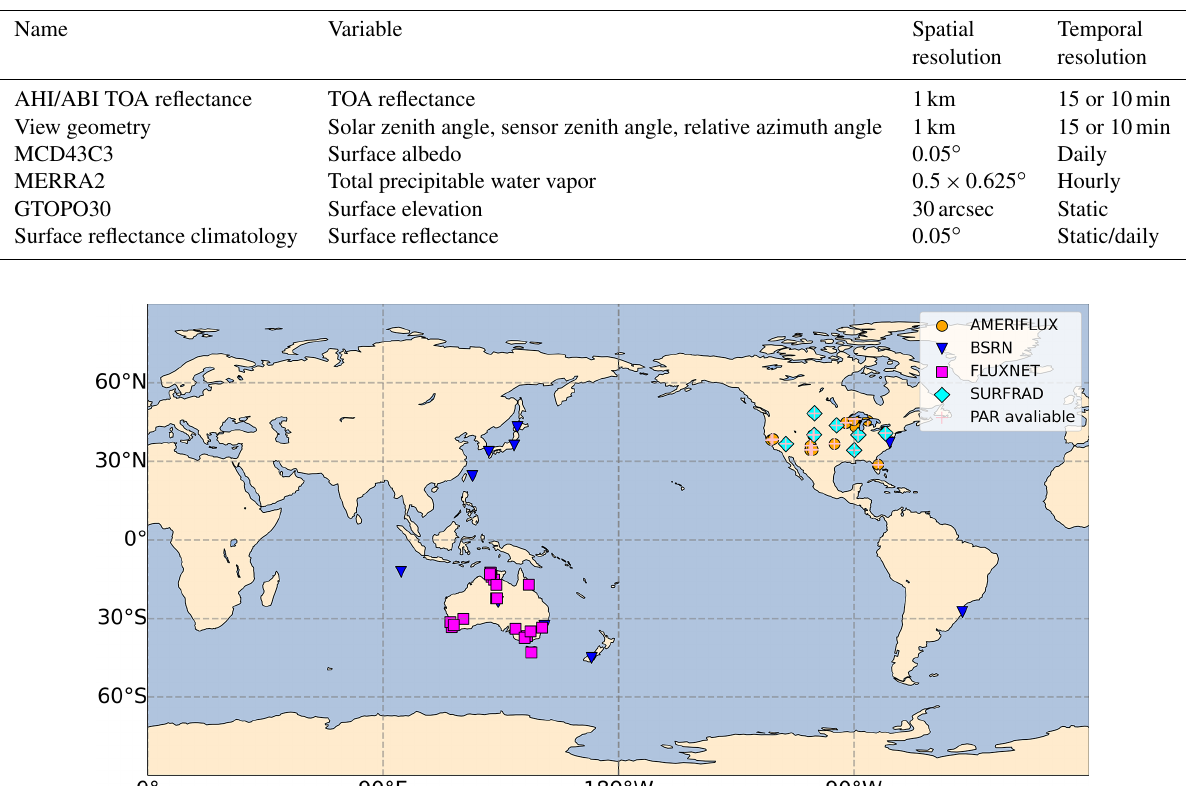
version of MCD18A1 has also been included in the compar- ison (D. Wang et al., 2020). It applied a similar LUT method over MODIS TOA reflectance and estimated DSR at a global scale at 1 km spatial resolution with 3-hourly and daily inter- polated temporal